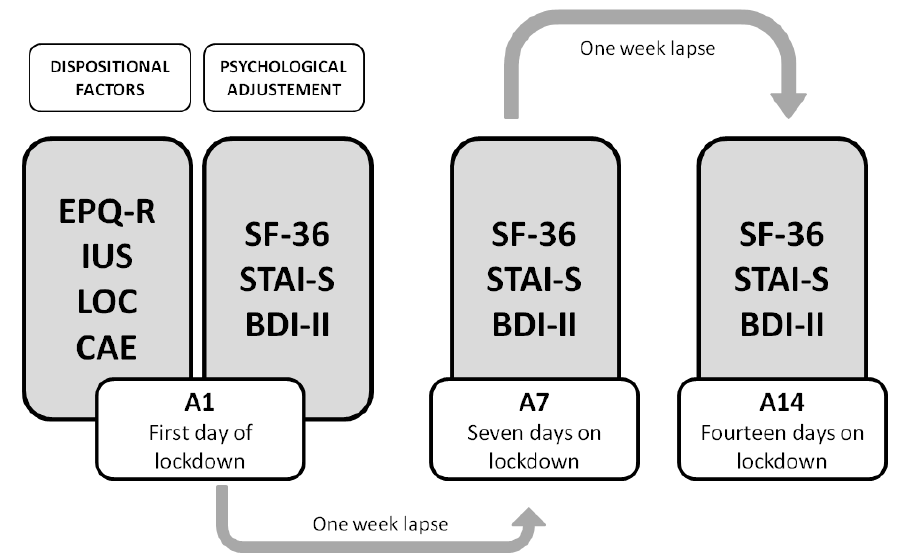
Figure 1. Procedure of the study, with the three assessment stages: A1, A7, and A14.